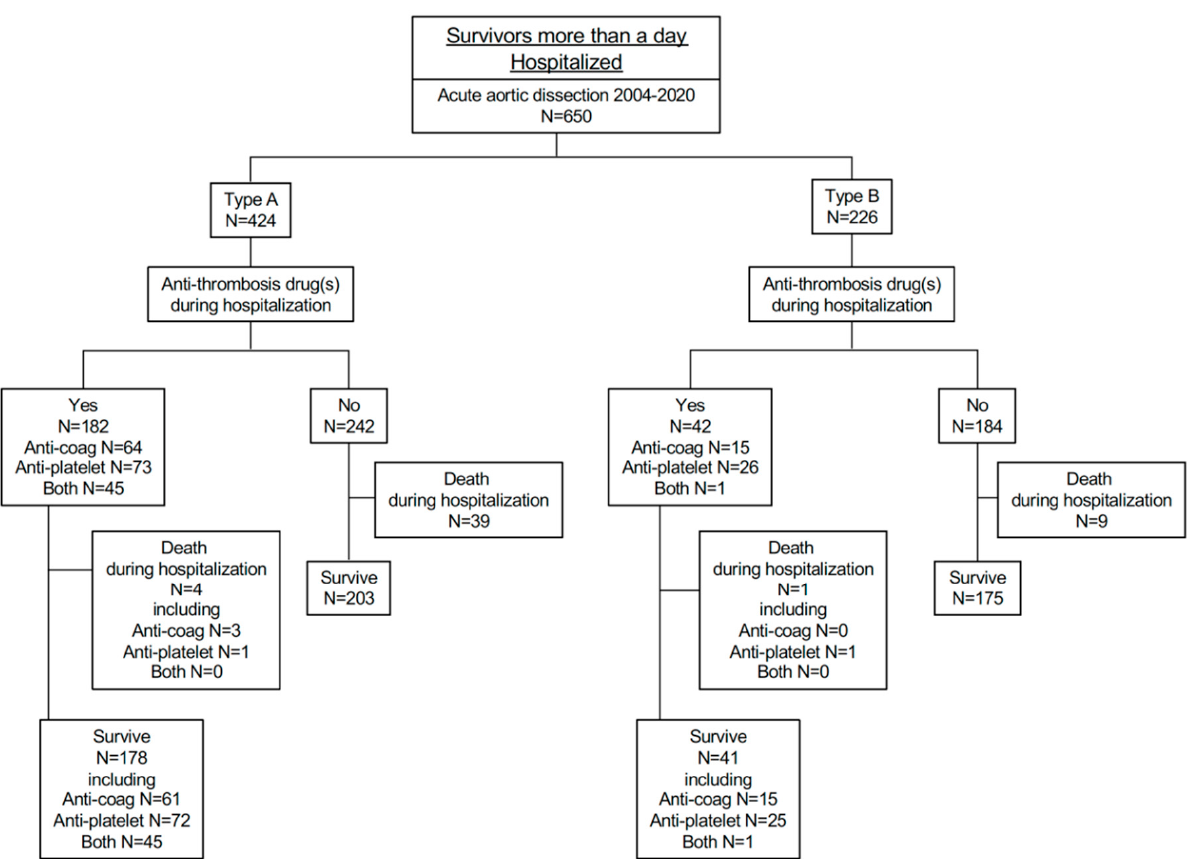
Figure 4. Enrollment of hospitalized patients with acute aortic dissection.